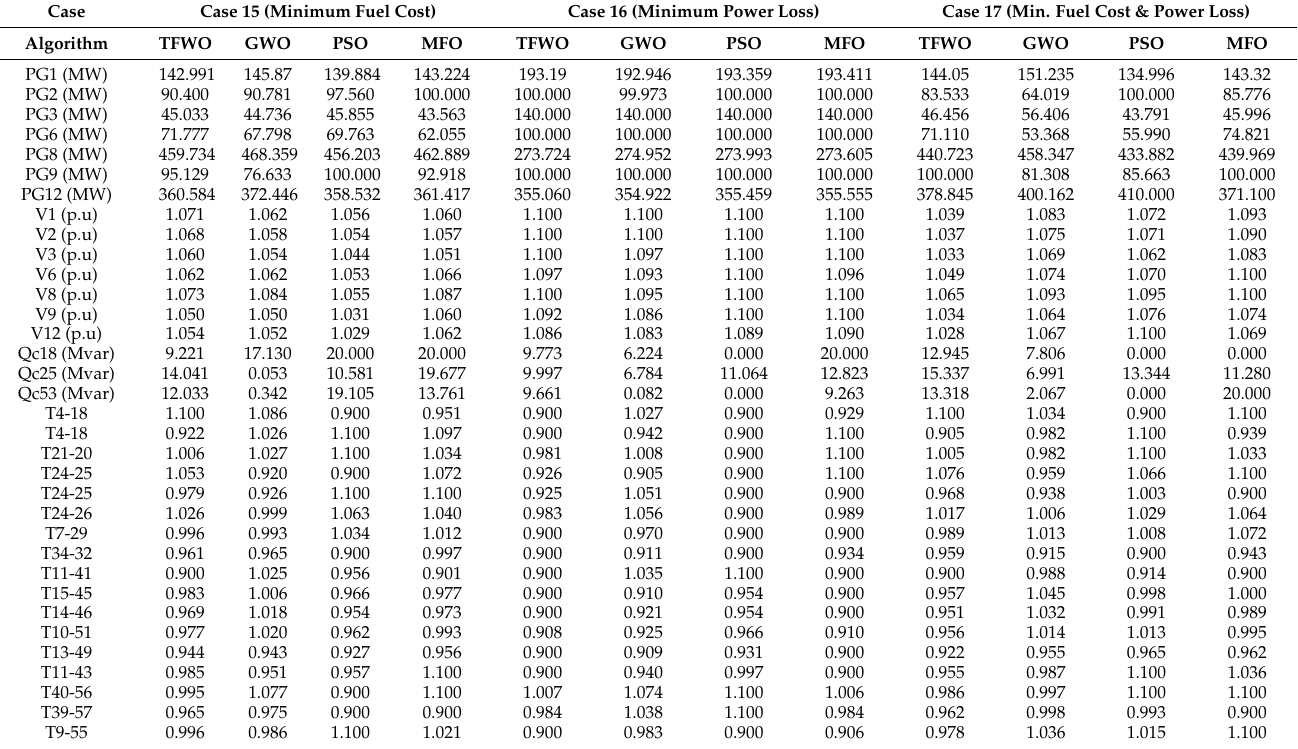
Table A3. Control variables settings for TFWO versus recent optimization algorithms (IEEE-57 bus test system) for Cases